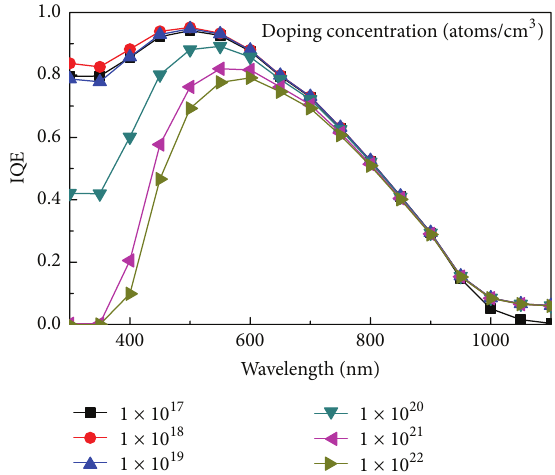
Figure 3: Variation of the internal quantum efficiency of the cell with different boron